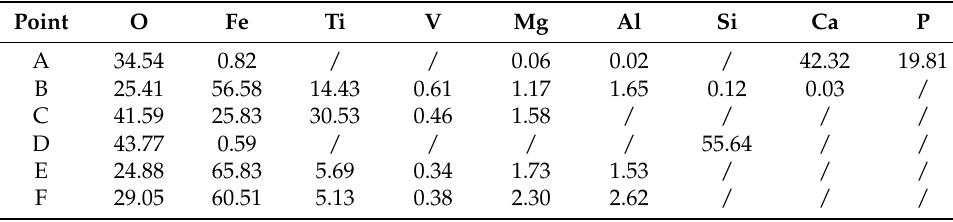
Table 6. Compositions of main phases in oxidized pellets with 40% sea sand ore detected by EDS (wt.